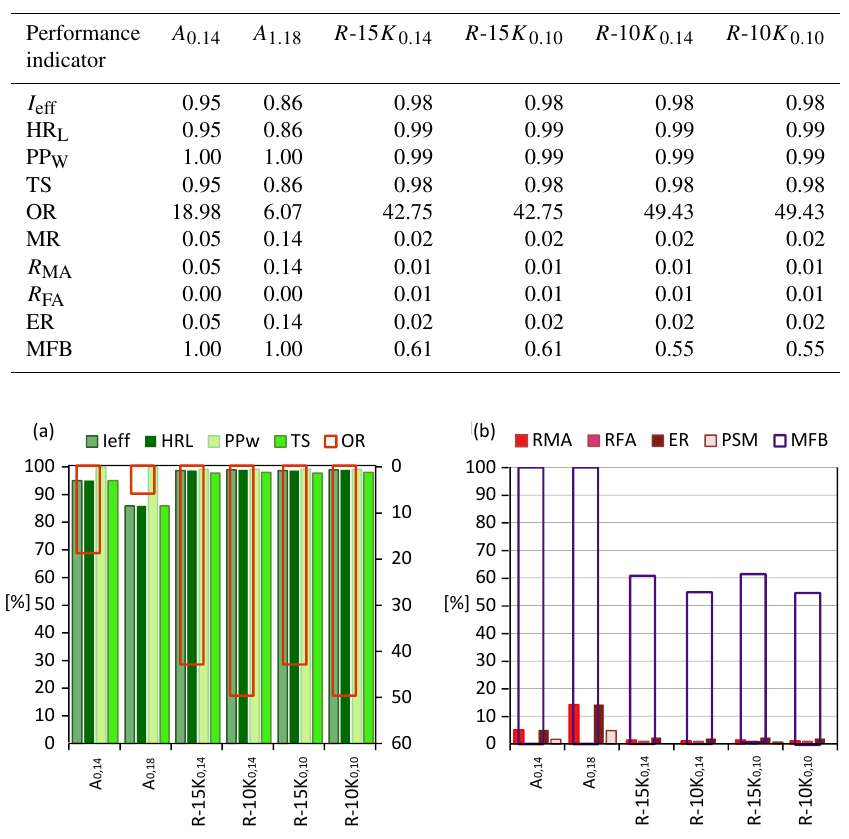
Table 9. Performance indicators for the six simulations of landslide density criteria considered in the parametric analysis.